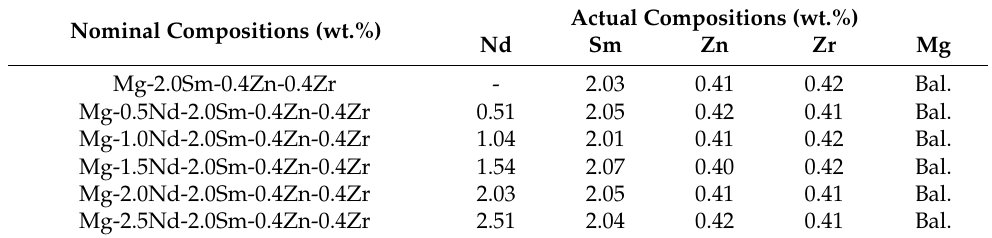
Table 1. Nominal compositions and actual compositions of Mg-xNd-2.0Sm-0.4Zn-0.4Zr alloys. Nominal Compositions